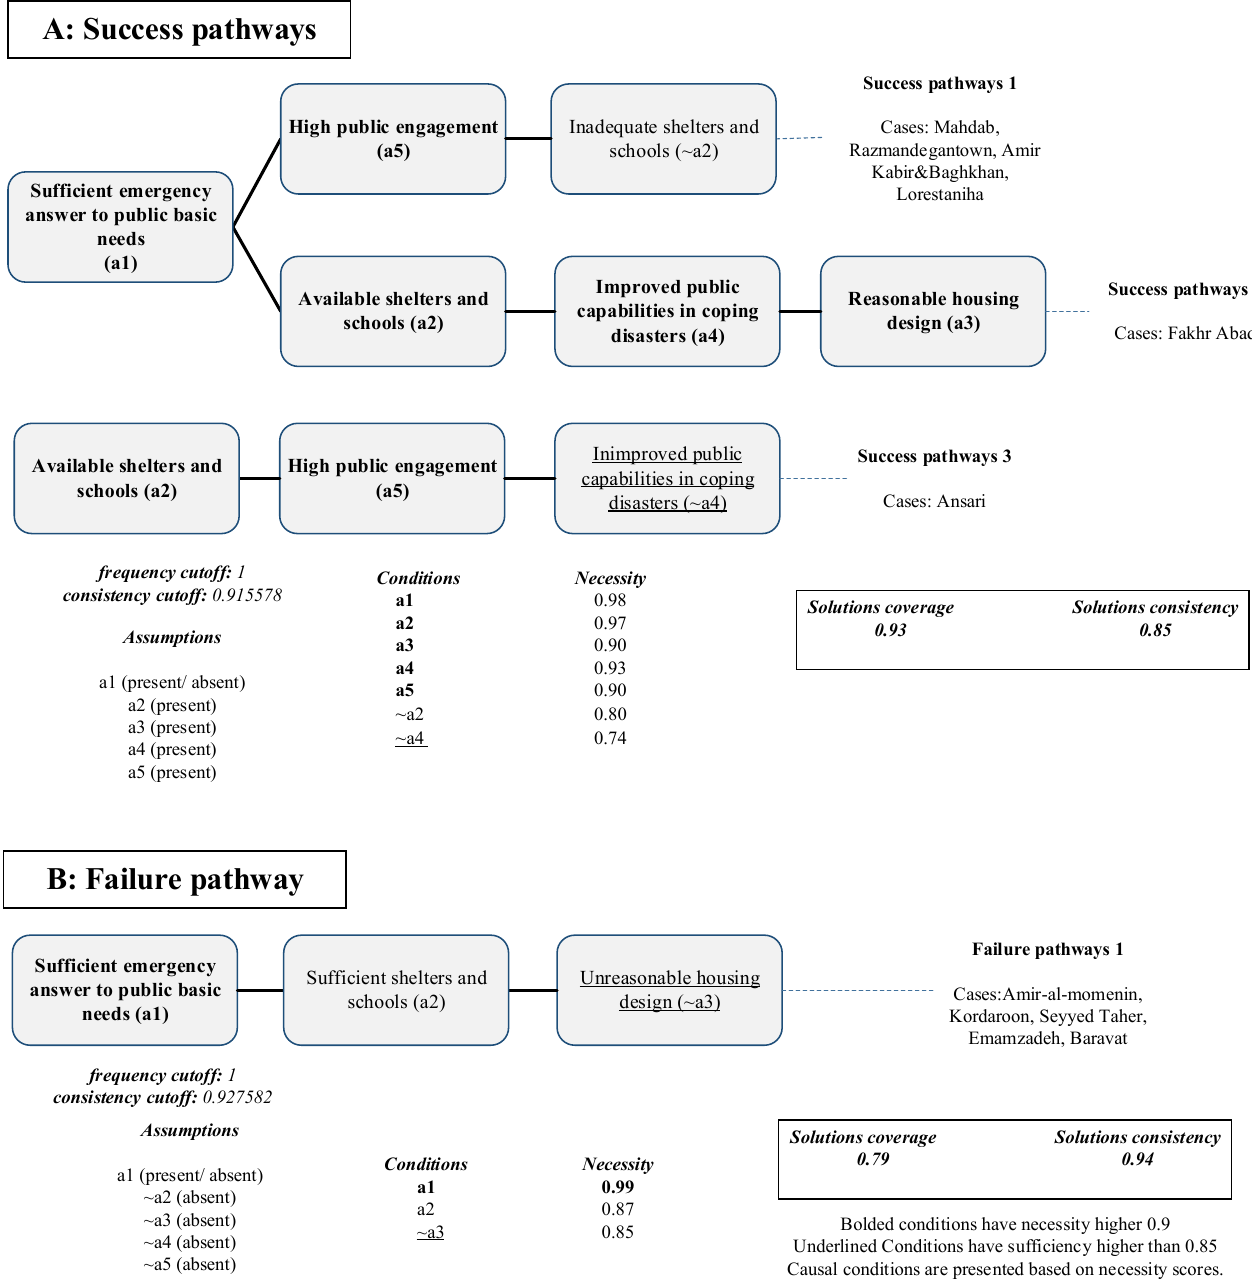
Figure 5. Success and failure pathways for outcome A1.